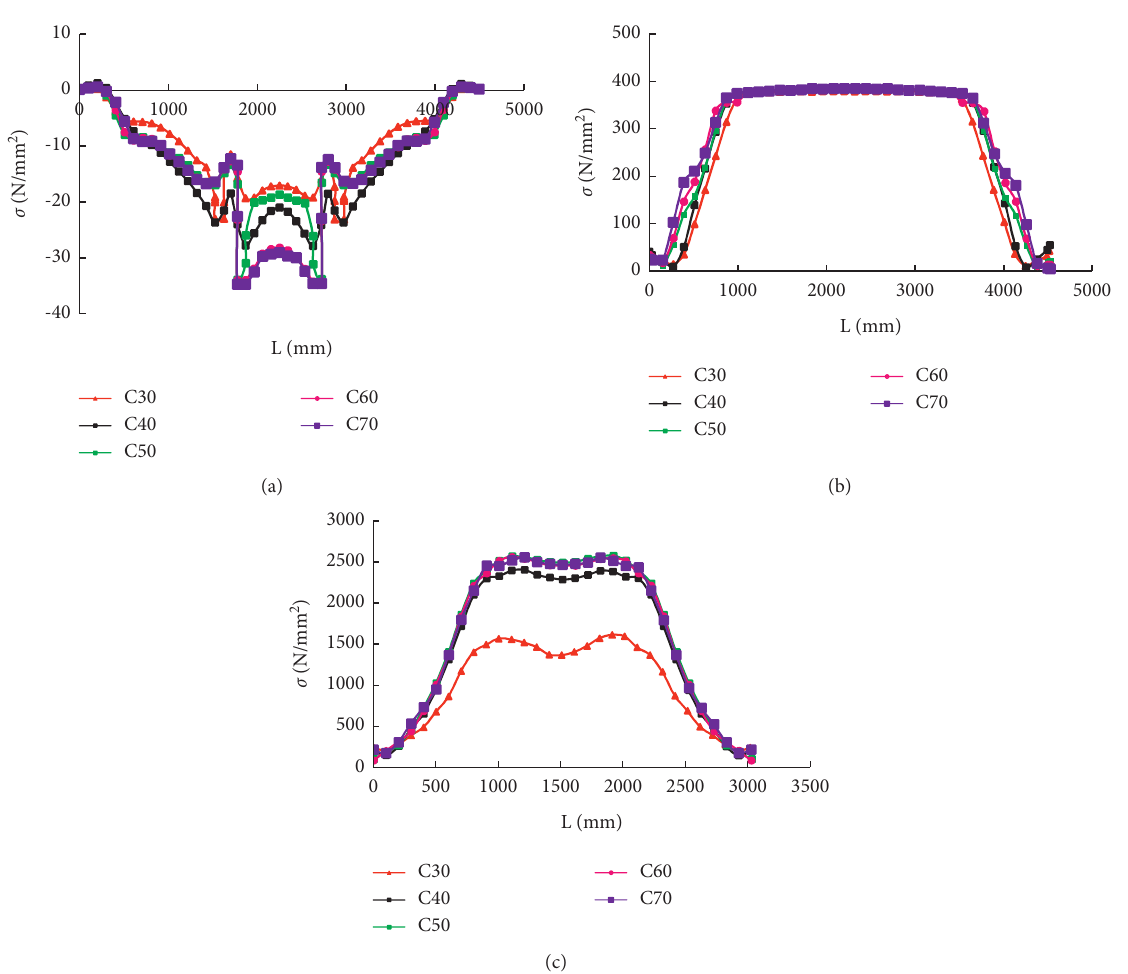
Figure 8: Section stress distribution along the beam length under different strength grades of concrete: (a) section of concrete, (b) section of steel reinforcements, and (c) section of CFRP strips.